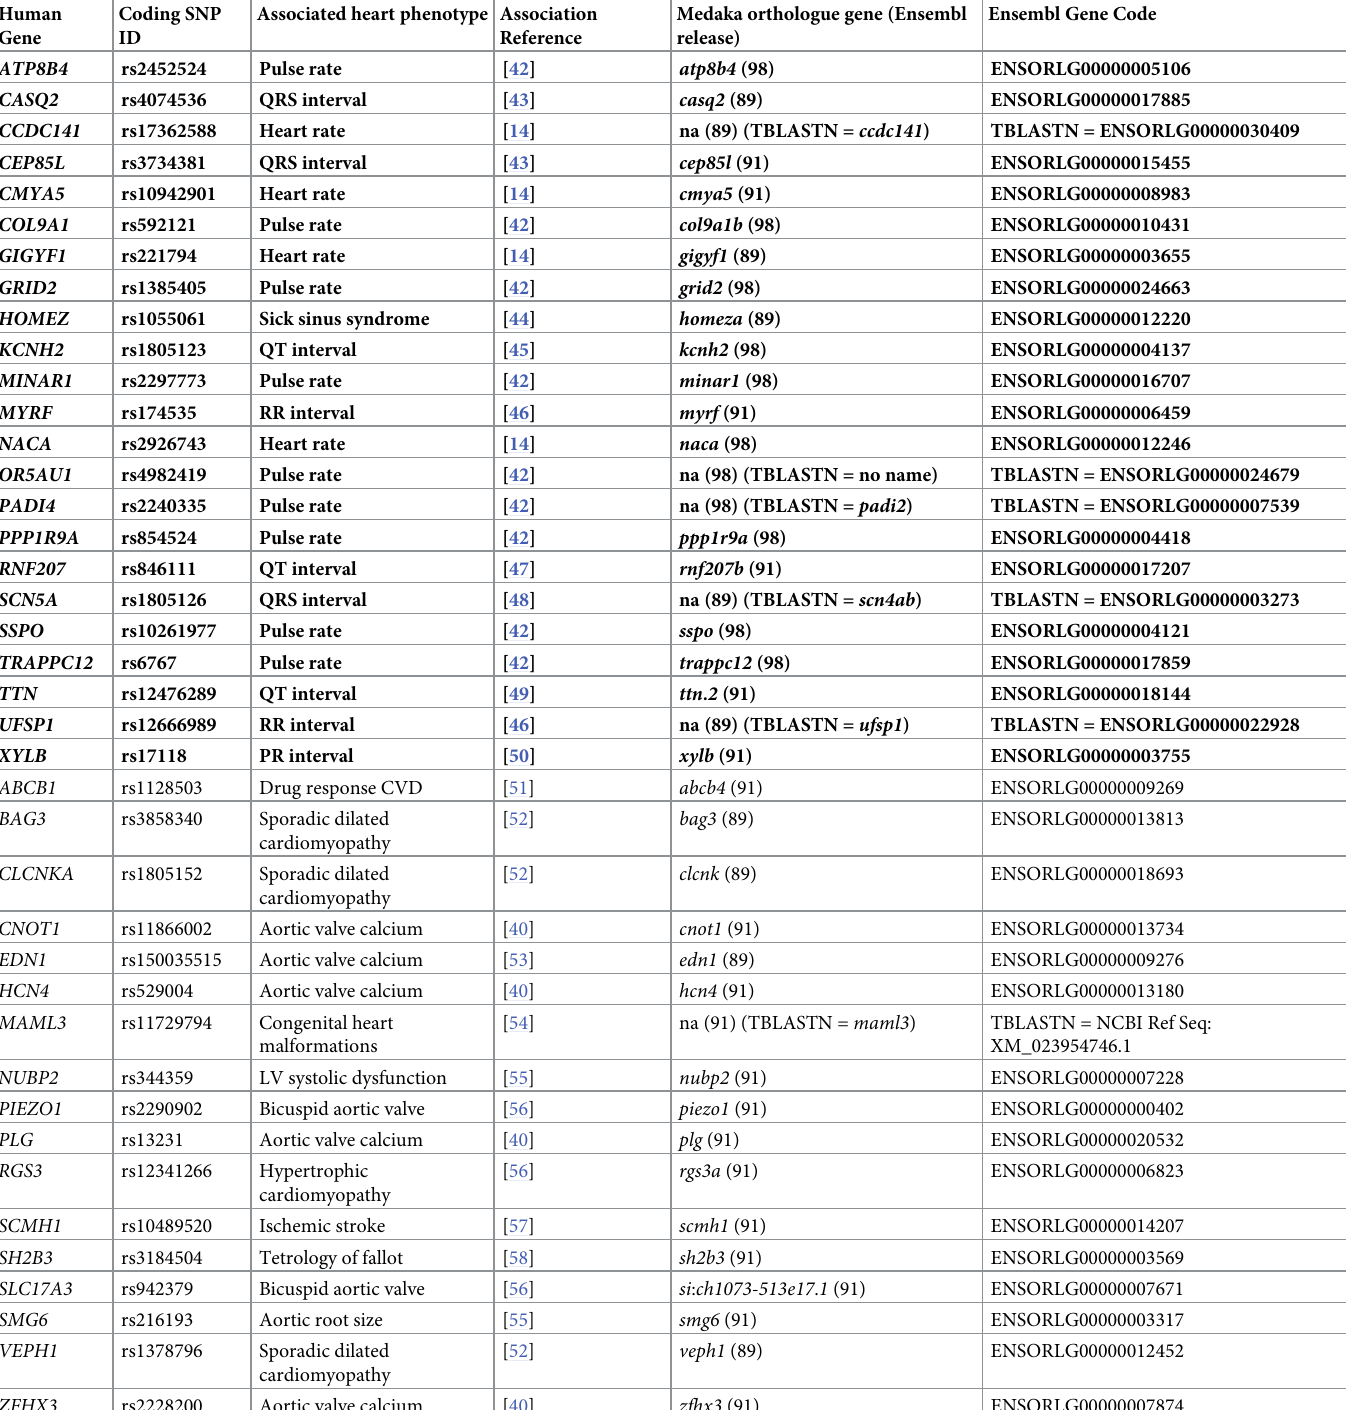
Table 2. List of candidate genes extracted from human GWAS using GRASP 2.0